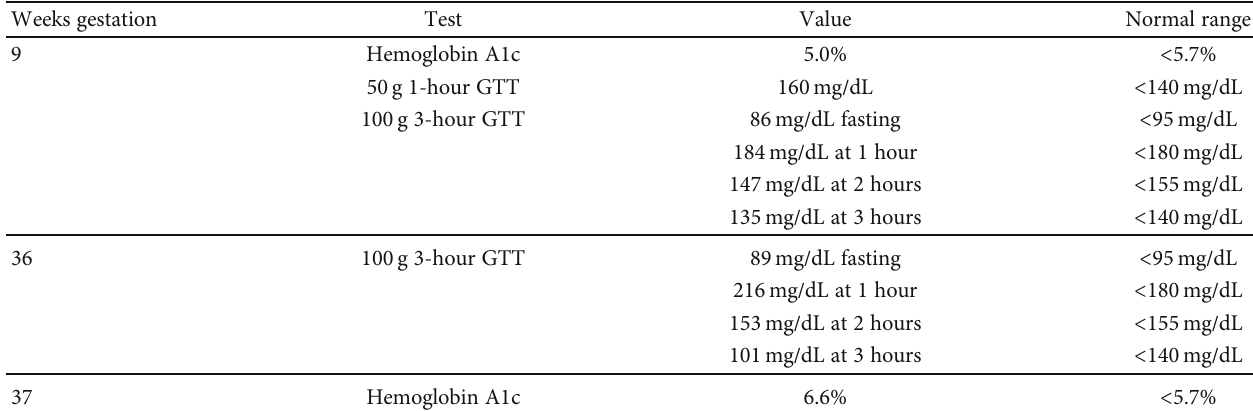
Table 1: Assessment of glycemic control in Case